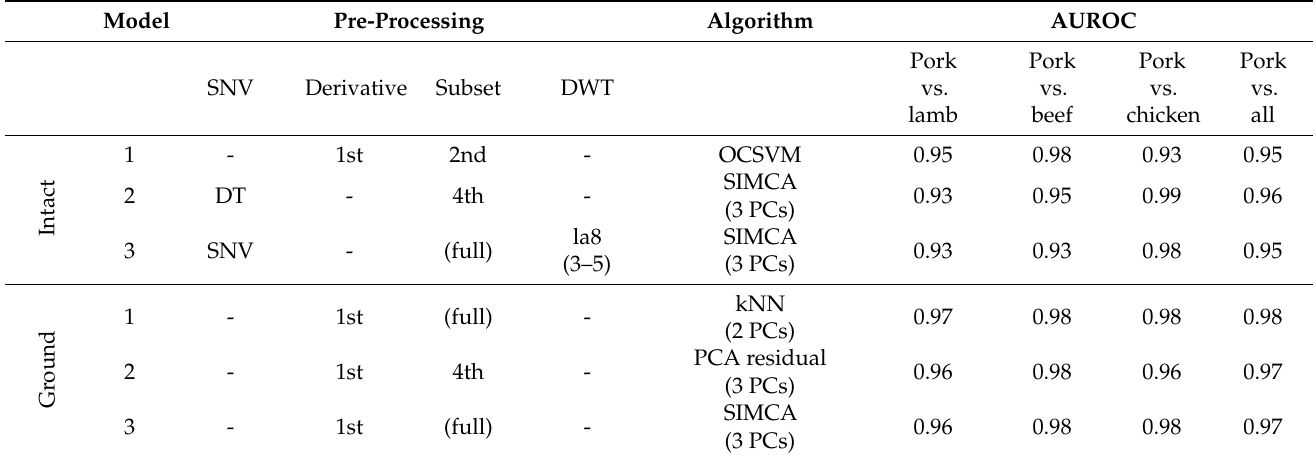
Table 2. Details and AUROCs on the manually picked models for the Vis-NIR sensor.